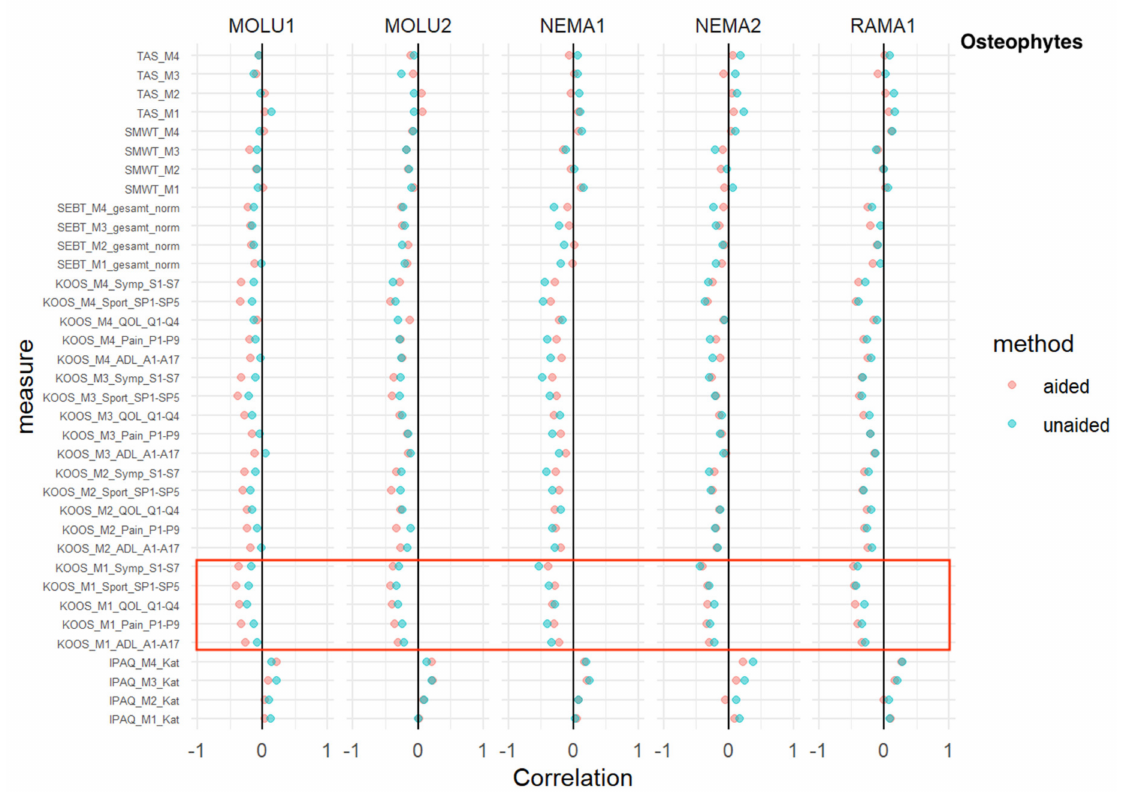
Figure 4. Osteophytes —correlation analysis for AI-aided (red dots) versus AI-unaided (green dots) readings with clinical scores. Red square marks all baseline KOOS scores (=“KOOS_M1_x_x”).